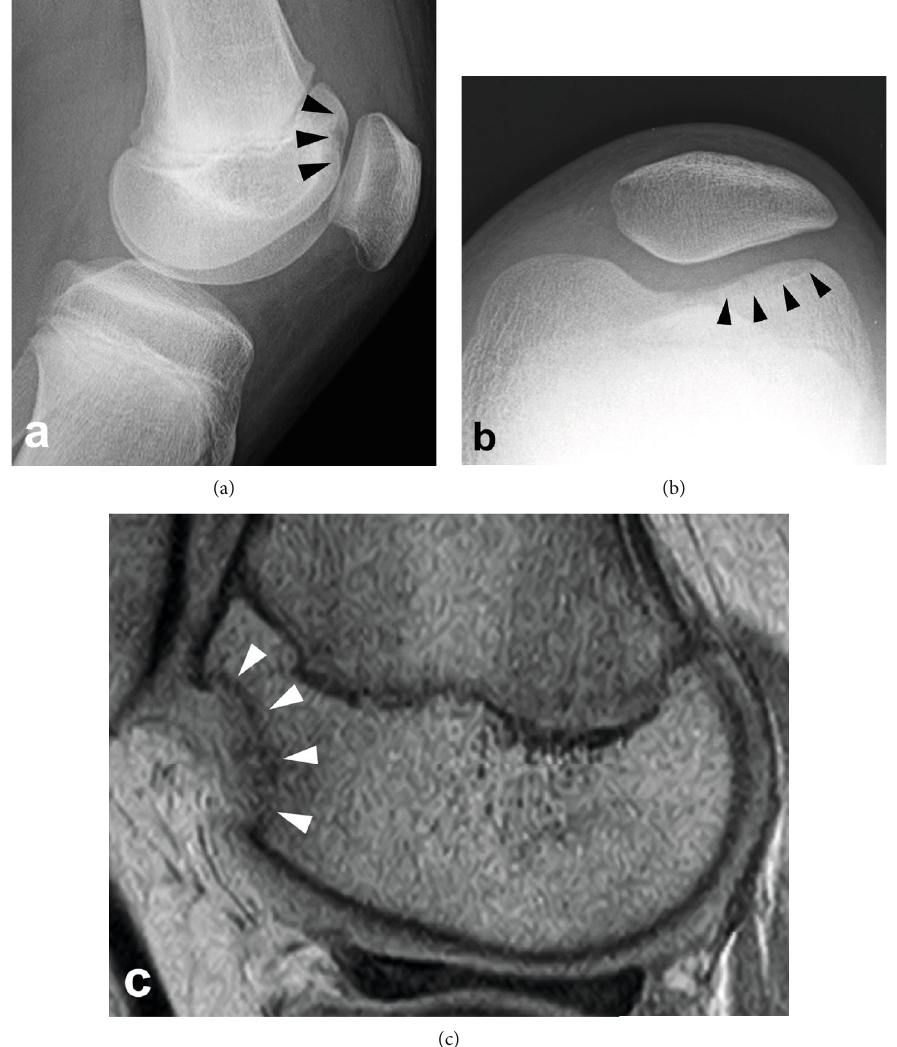
Figure 4: (a) Lateral view and (b) skyline view radiograph of the left knee showing Brückl ’ s stage V OCD lesion in the lateral facet of the femoral trochlea. (c) Proton density-weighted MRI sagittal image of the left knee indicating Nelson ’ s stage III lesion in the lateral facet of the femoral